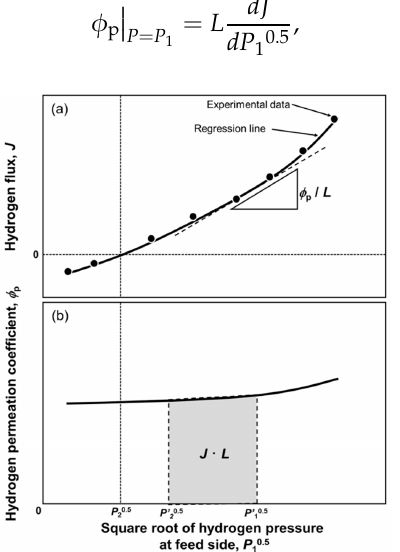
Figure 1. Schematic illustration of changes in ( a ) the hydrogen flux ( J ) and ( b ) pressure-dependent hydrogen permeation coe ffi cient as a function of the square root of hydrogen pressure at the feed